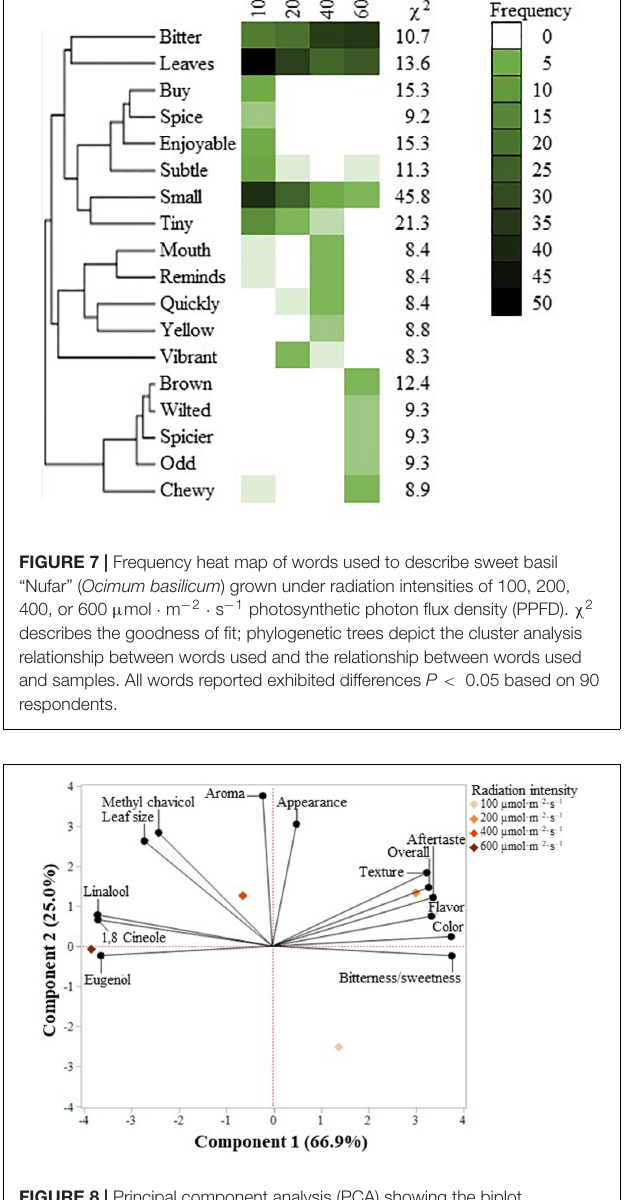
FIGURE 8 | Principal component analysis (PCA) showing the biplot differentiation of sweet basil “Nufar” ( Ocimum basilicum ) grown under 100, (PPFD), based on consumer sensory preferences ( n = 90) and the concentration of two terpenoids and two phenylpropanoids ( n =